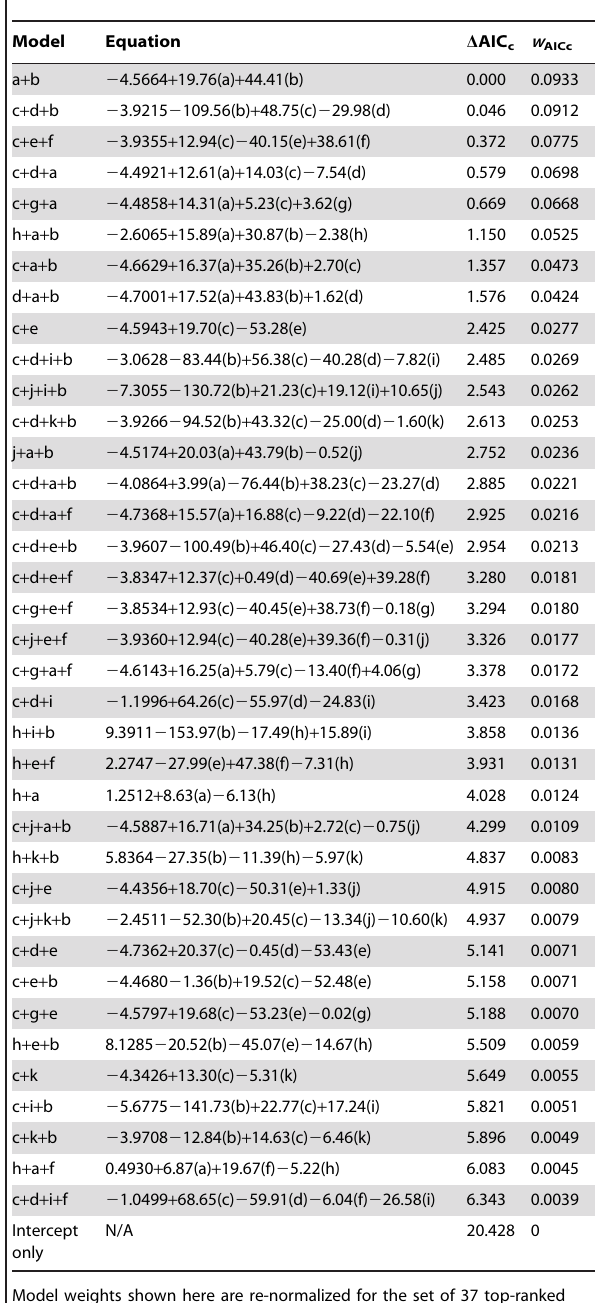
Table 3. Summary of the 95% confidence set (37 of a total of 139 candidate models) of candidate models used to generate map of mortality rates, showing intercepts, estimated coefficients, D AIC c and w AICc . Intercept only model included at bottom for